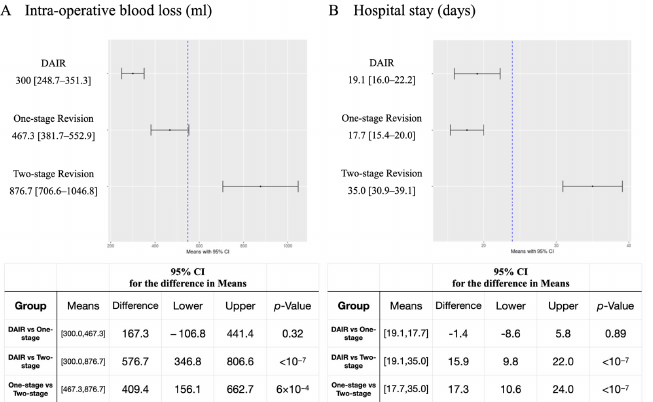
Figure 2. Tukey–Kramer HSD post hoc test of intraoperative blood loss and hospital stay. ( A ) In ‐ traoperative blood loss, ( B ) hospital stay .